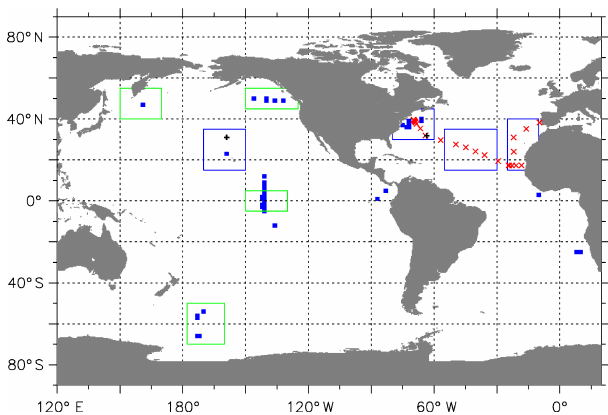
Figure 2. Vertical distribution along the Equator of the ratio be- tween the remineralisation rate of small POC computed when the assumption of a closed system is made and the remineralisation rate is computed in the standard RC experiment. Table 2. Model simulations.